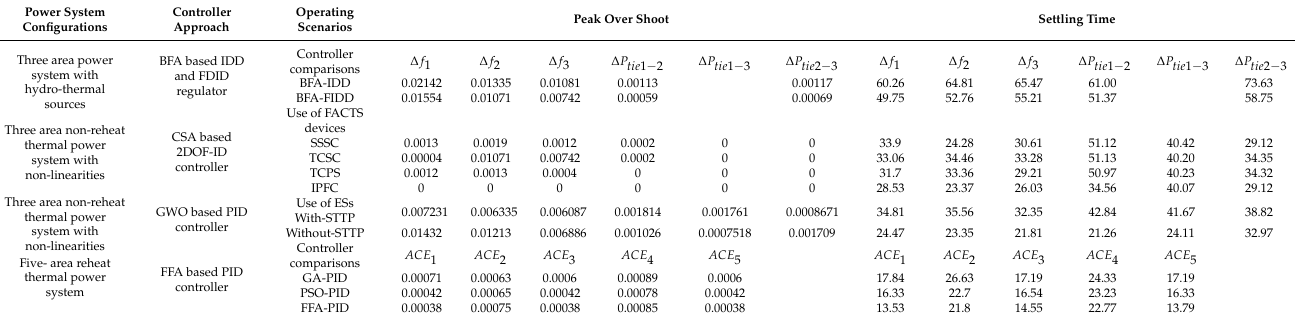
Table 4. Performance evaluation of AGC in three and five area power systems under different